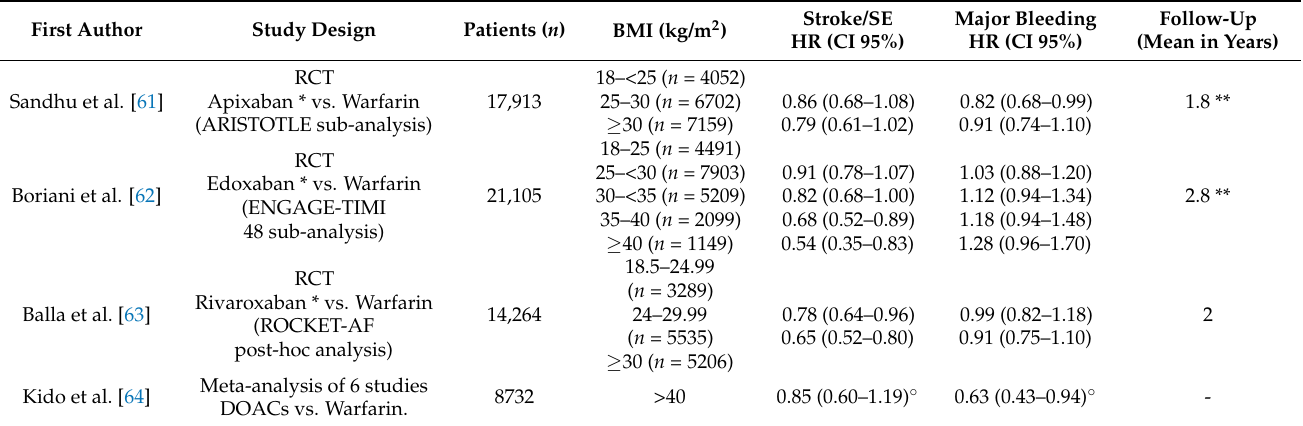
Table 3. Main studies that investigated the efficacy and safety of DOACs in obese